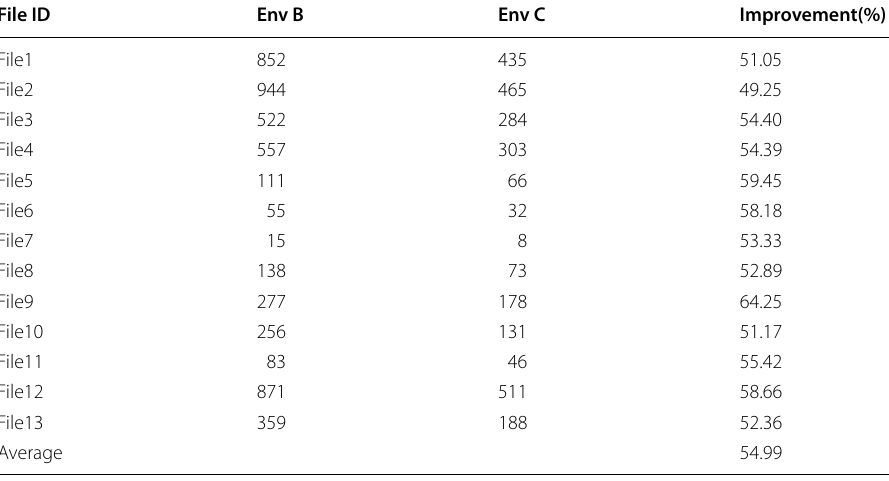
(in seconds) for different BIM data (in DC time